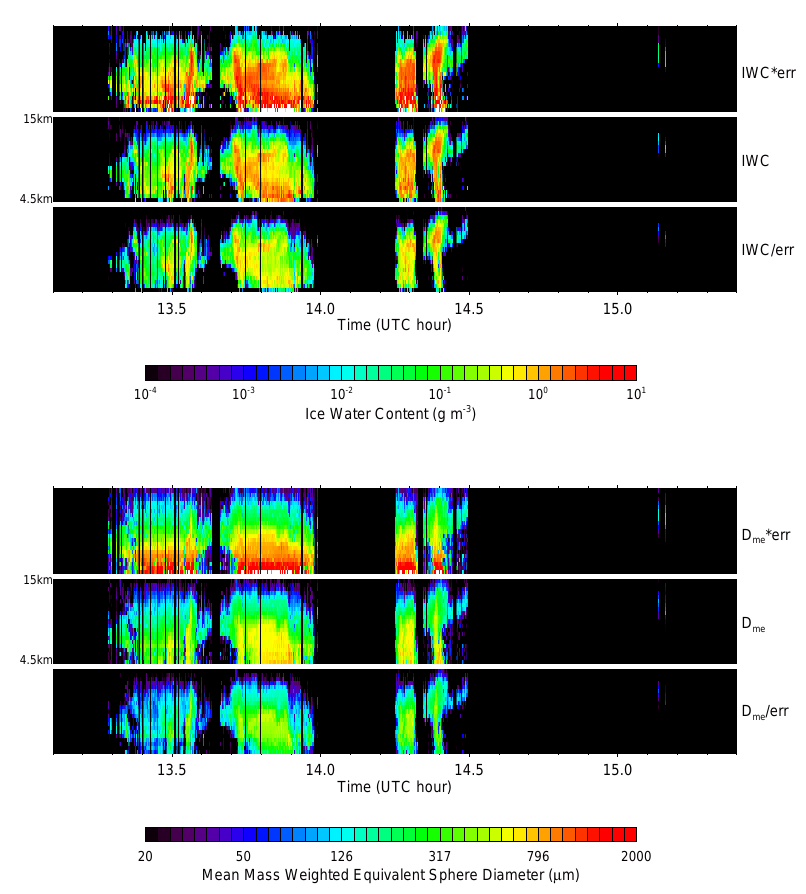
Fig. 21. Ice water content and D me profiles retrieved from nadir CoSSIR and Cloud Radar System data.